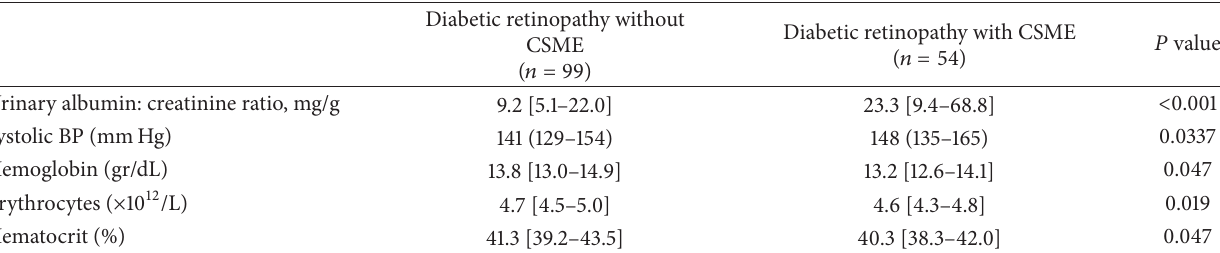
Table 4: General and hematological variables that showed statistically significant differences in the comparison between groups according to the presence or absence of CSME in the group patients with diabetic retinopathy. Diabetic retinopathy without Diabetic retinopathy with CSME ( 𝑛 = 99 )